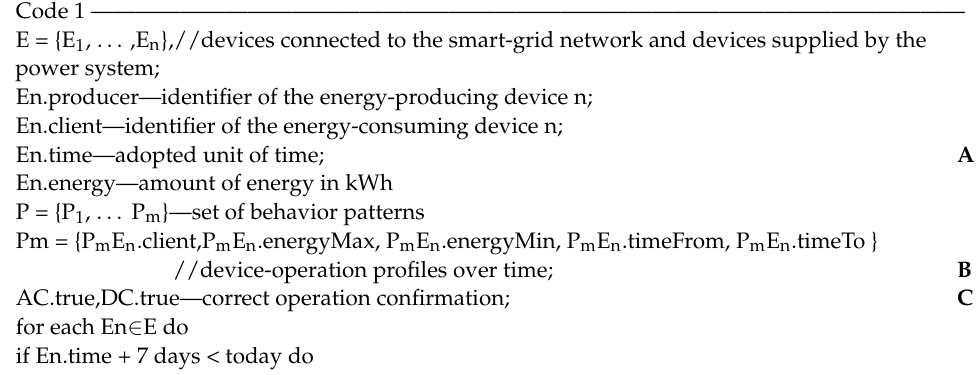
Algorithm 1. Simplified algorithm for a profiling agent.